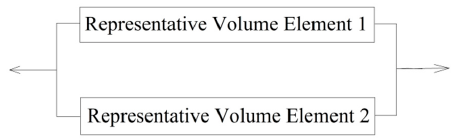
Figure 3. Sketch of a two-element parallel system.